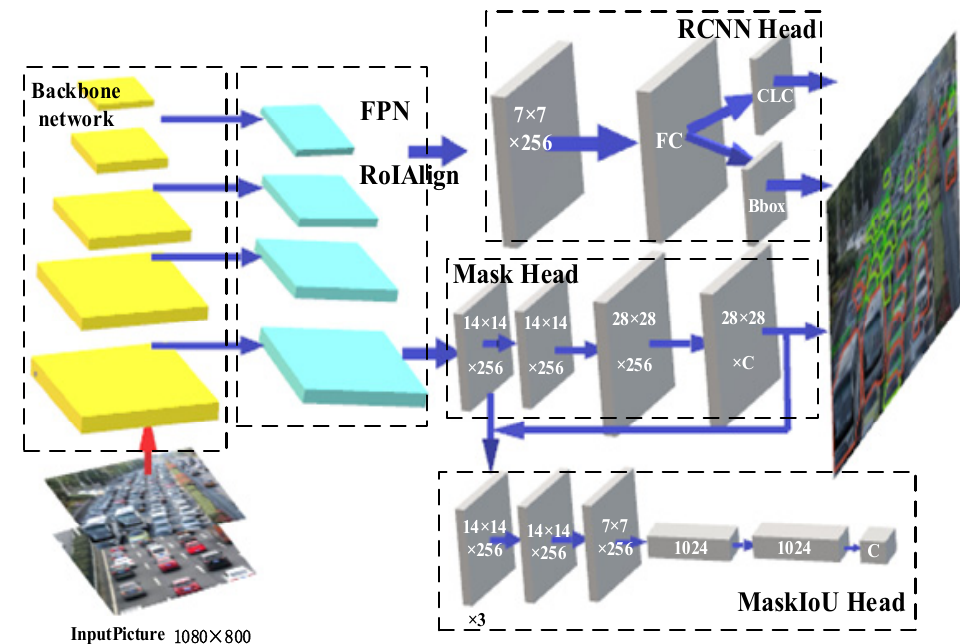
Figure 6. The recognition structure with contour enhancement using CQE.